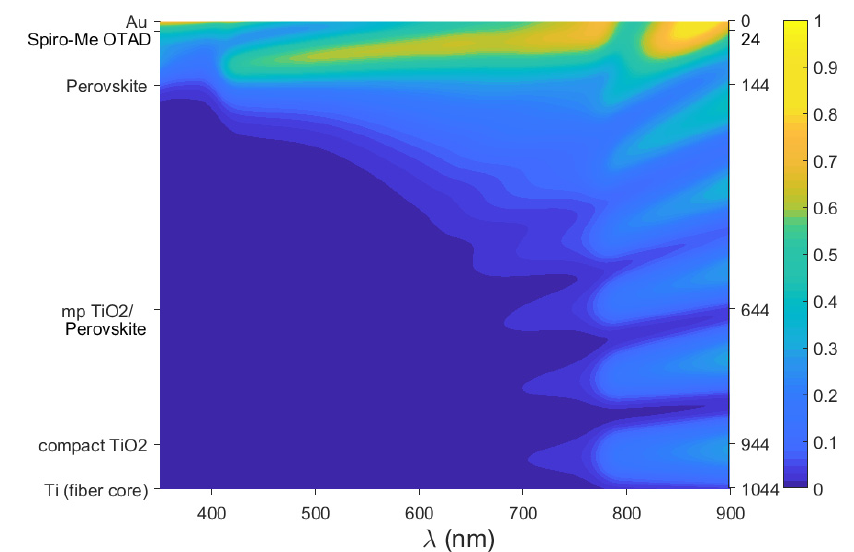
Figure 10. Distribution of the intensity of the electric filed inside the structure for normal-only inci- dence.